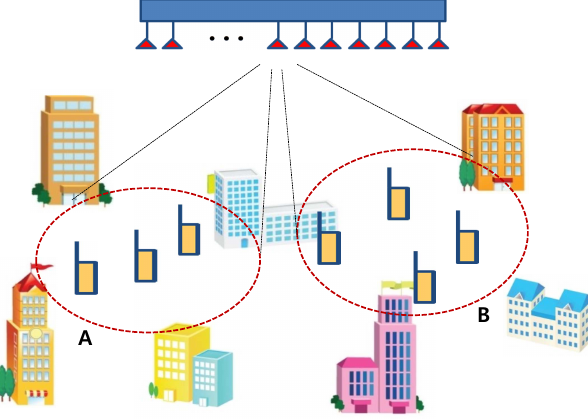
Figure 1. The high level concept of beam grouping resource reuse